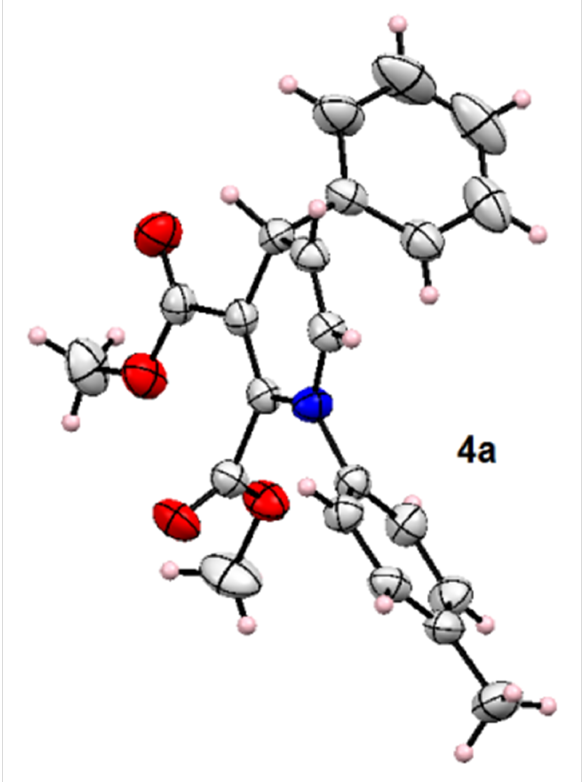
Figure 6: ORTEP representation of product 4a (CCDC